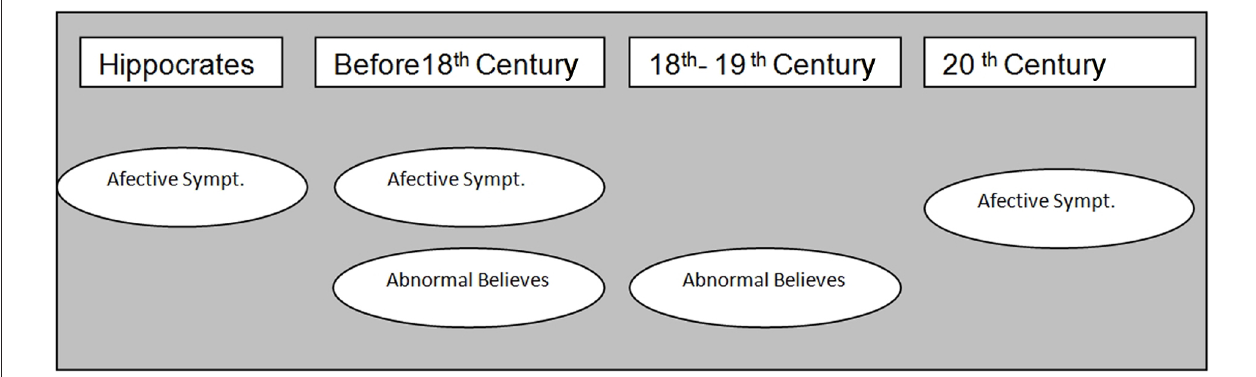
FIGURE 1 | Evolution of the meaning of the term melancholia throughout history.